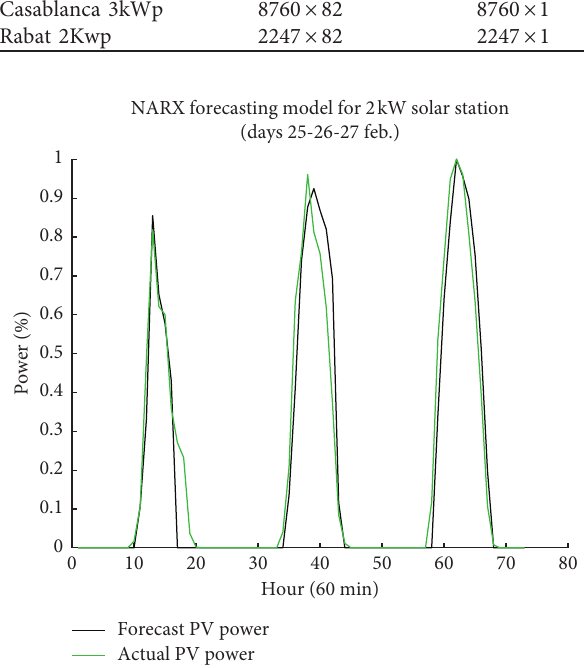
Figure 12: NARX neural network for forecasting days 25, 26, and 27 February of the year.